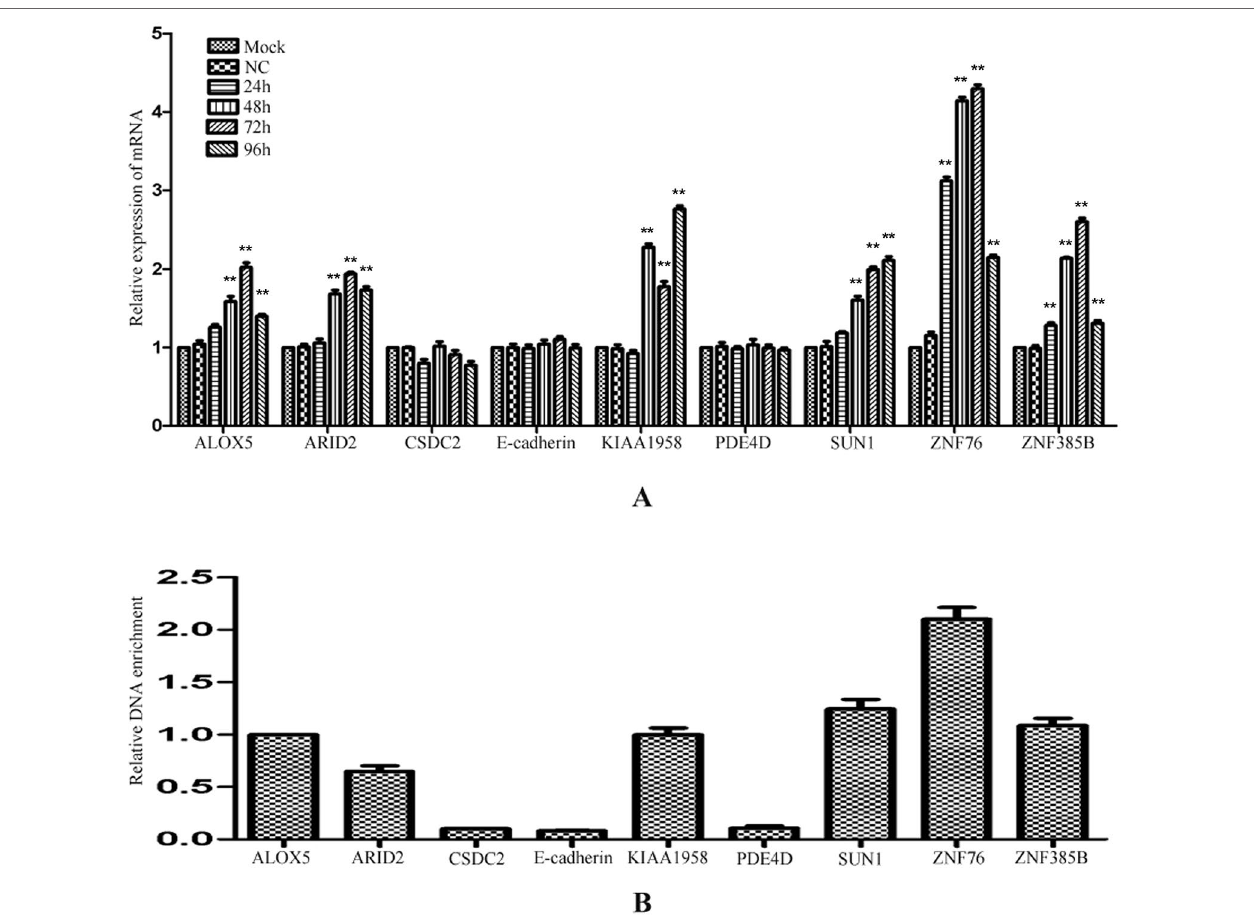
FIGURE 5 | The regulation of identified genes by miR-373 in HeLa cells. (A) HeLa cells were transfected with miR-373 or NC-miRNA. Cells were harvested after 24, 48, 72, or 96 h post-transfection. Real-time PCR was used to measure the mRNA level of ALOX5, ARID2, E-cadherin, KIAA1958, PDE4D, SUN1, ZNF76, and ZNF385B genes. The expression of β -actin was used as the internal reference. n = 3, * P < 0.05, ** P < 0.01 compared with the sample transfected with NC miRNA. (B) Bio-miR-373 or bio-NC-miRNA was transfected into HeLa cells. After 24 h post-transfection, DNA–miRNA pull-down assays were performed to enrich the miR-373 binding sequences. Then real-time PCR was performed to detect the enrichments of the genomic sequences in ALOX5, ARID2, E-cadherin, KIAA1958, PDE4D, SUN1, ZNF76, and ZNF385B genes. U6 fragments added in the samples were taken as an endogenous